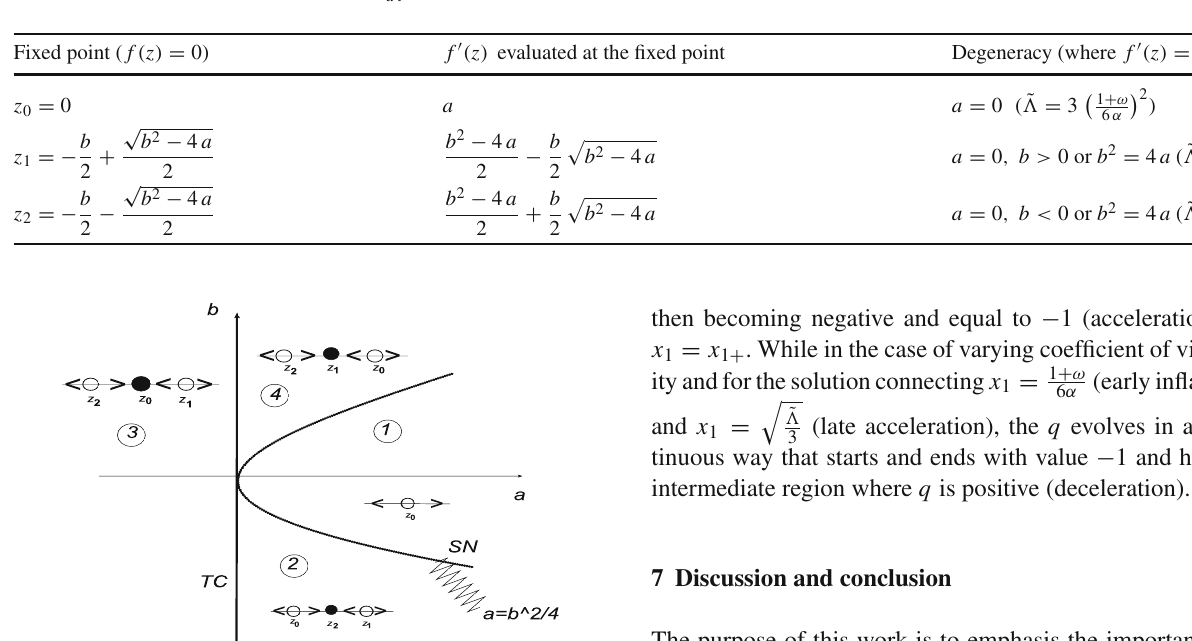
= f ( z ) ≡ z 3 + b z 2 + a z corresponding to the flat case with variable viscosity coefficient, ˜ ξ = α x d τ